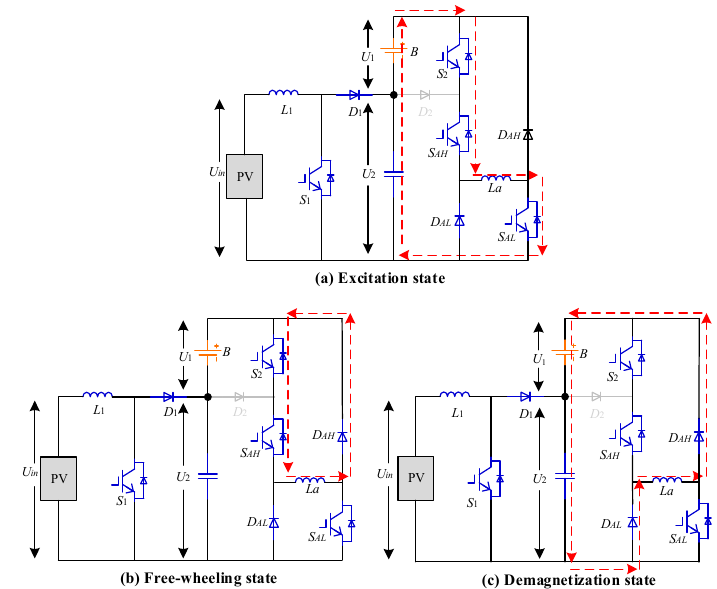
Figure 9. Working states of mode 3. ( a ) Excitation state. ( b ) Free-wheeling state. ( c ) Demagnetization state.